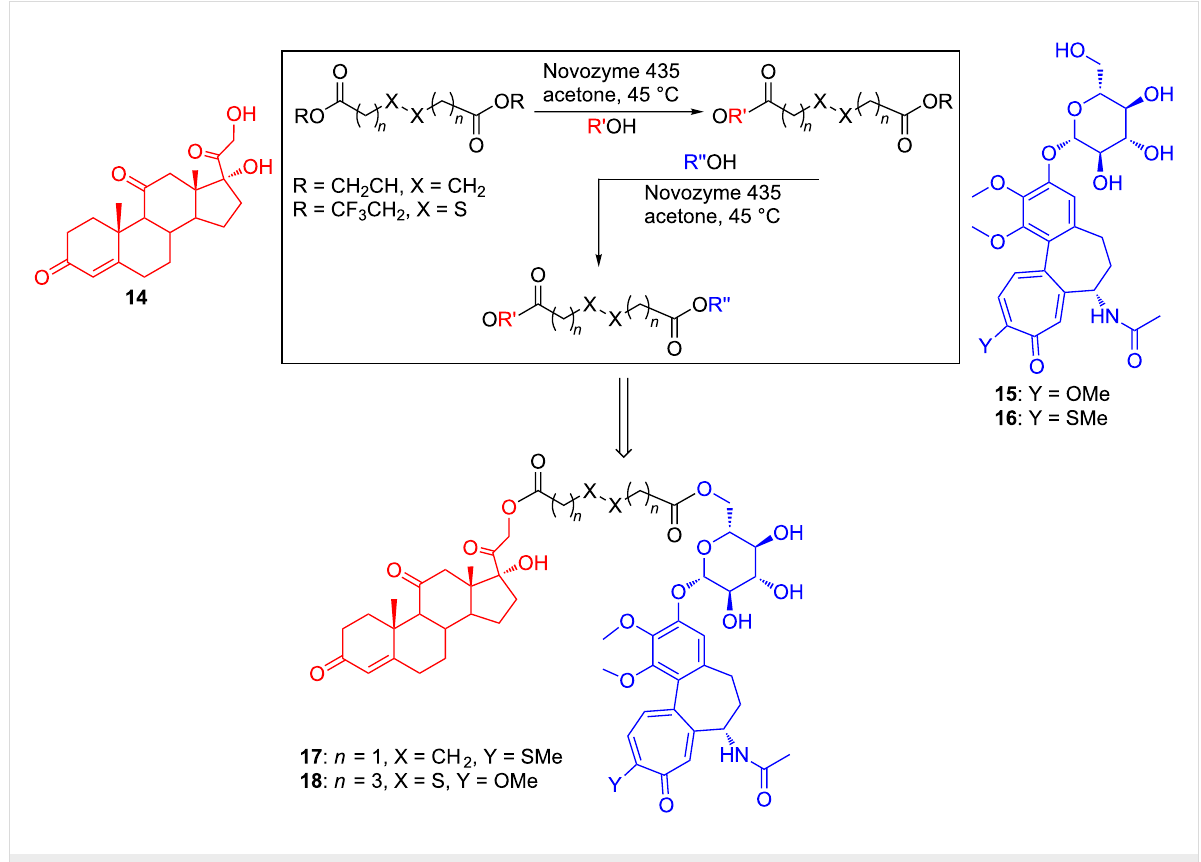
Scheme 3: Biocatalyzed synthesis of hybrid diesters 17 and 18